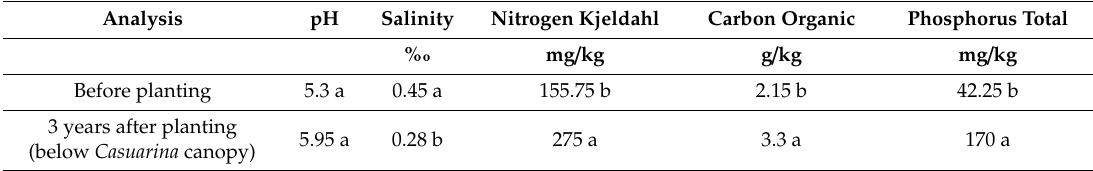
Table 1. Chemical characteristics of soil before planting in 2013 and 3 years after planting. Lower-case letters (a–b) indicate significant di ff erences between before planting and 3 years after